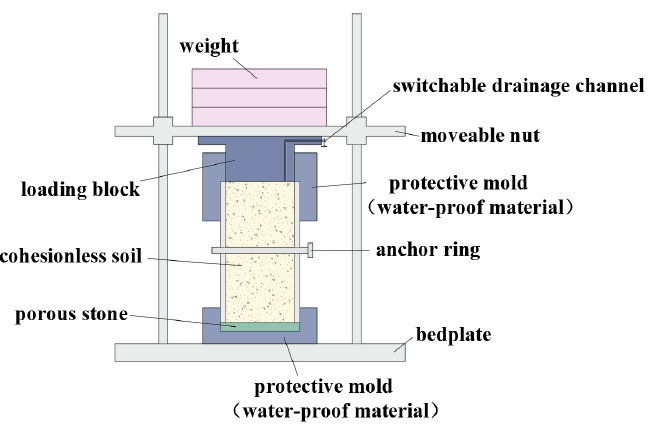
Figure 5. Freeze–thaw device diagram.